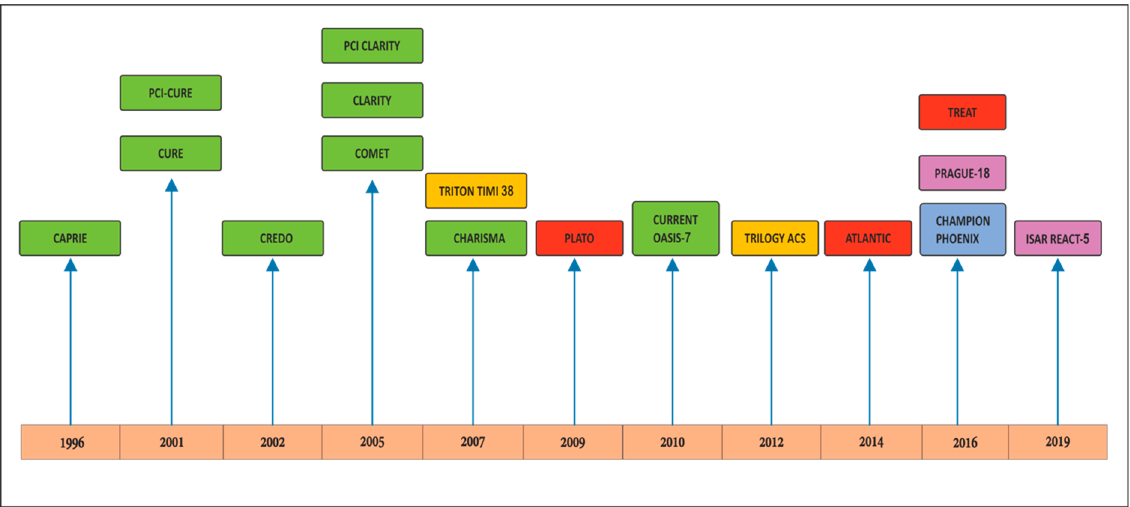
Figure 1. Timeline of P2Y12 inhibitor trials over the past 25 years. The green boxes represent clopidogrel trials, the yellow boxes prasugrel trials, and the red boxes contain ticagrelor trials. The blue box represents the cangrelor trial while the purple ones represent studies comparing ticagrelor versus